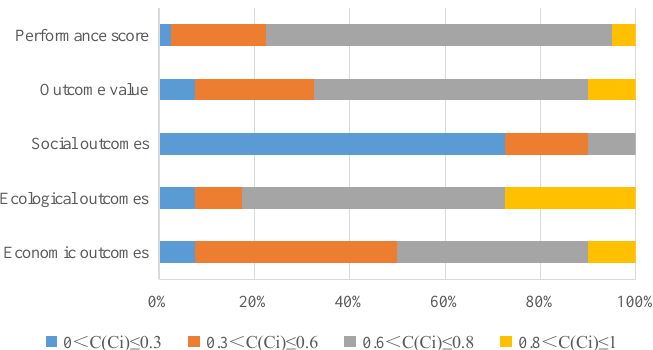
Figure 6. Distribution of performance value of outcome dimension in different interval. Note ： Ci indicates the relative gray closeness of each component. C indicates the relative gray closeness of outcome dimension and the overall performance.